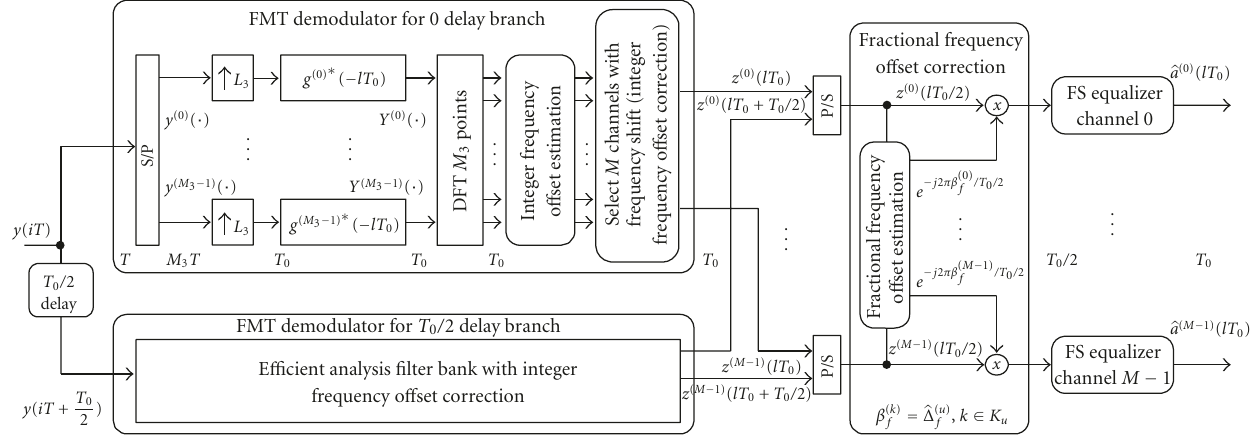
Figure 2: E ffi cient implementation of the fractionally spaced multiuser